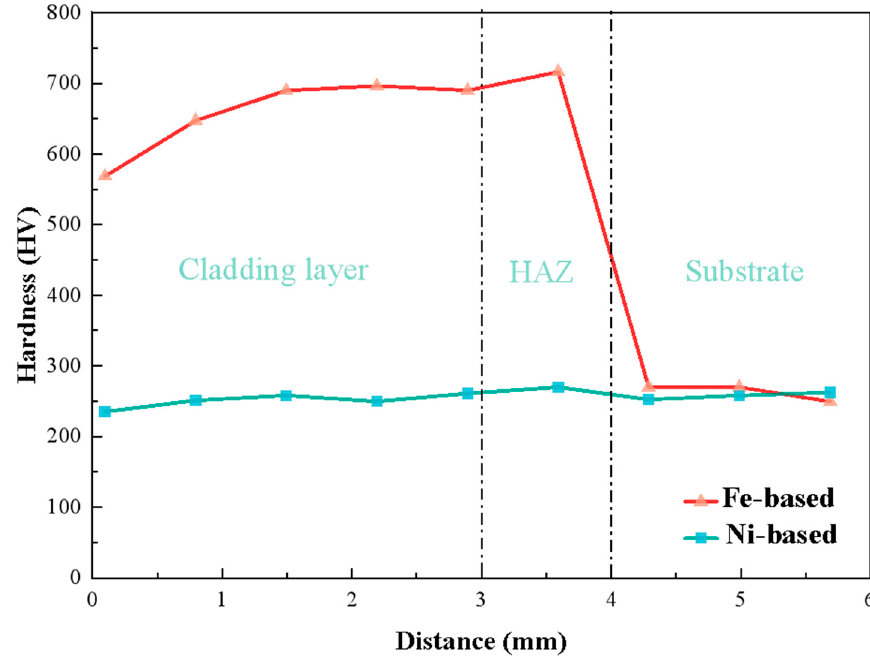
Figure 16. Microhardness of two samples.